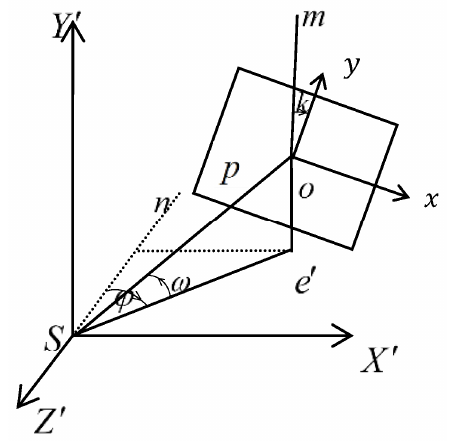
Figure 6. Ship Fixed Photogrammetry coordinate system and Ship Fixed coordinate system.